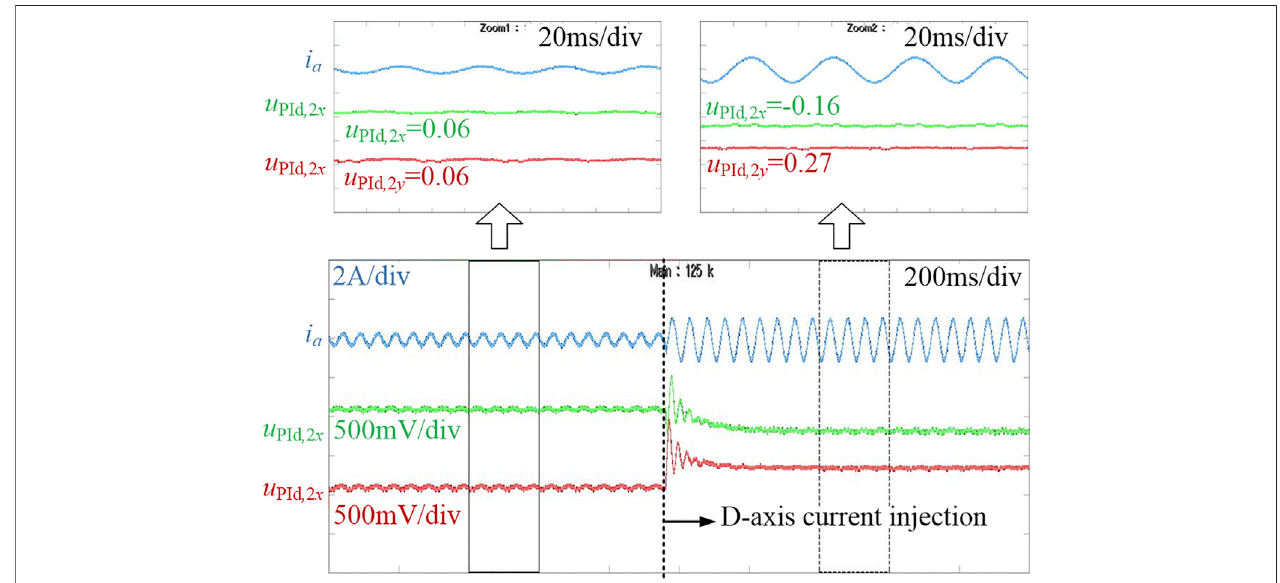
FIGURE 19 | Stator current, extracted u PId,2 x , and u PId,2 y of the PM machine with d -axis current injection.